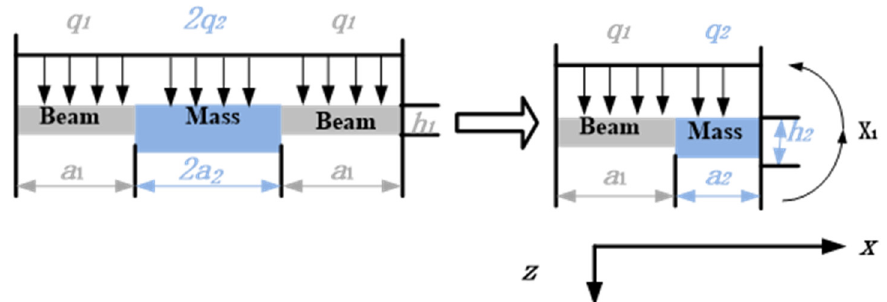
Figure 4. HGMA’s mechanical model.